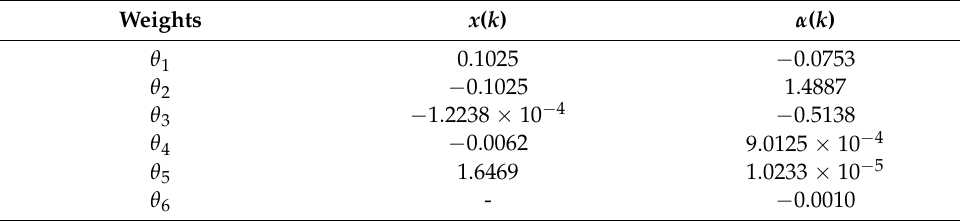
Table 7. Gene weights for the position and sway